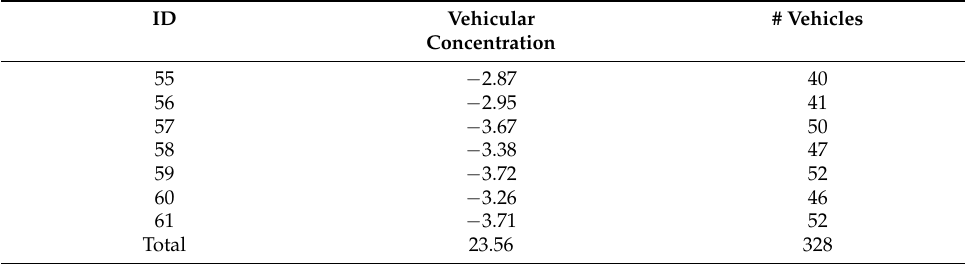
Table 3. Partial demand for each charging station at hour 07:00